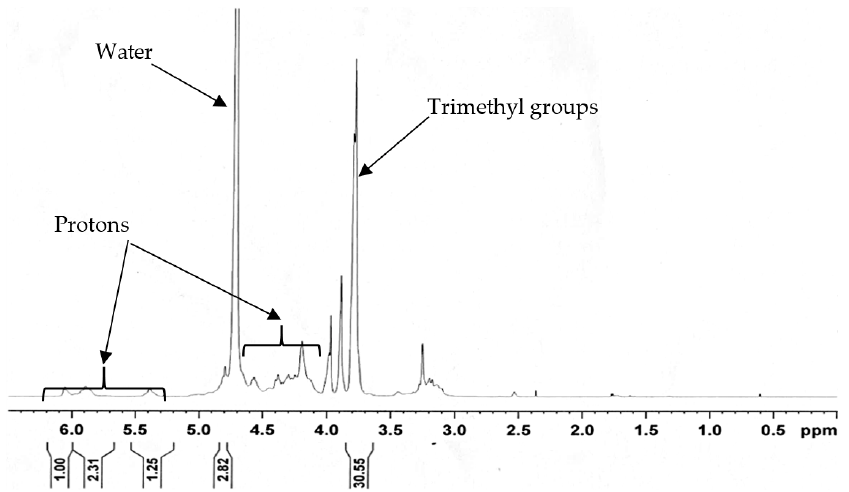
Figure 1. Proton nuclear magnetic resonance ( 1 H-NMR) spectrum for the N -trimethyl chitosan chloride (TMC).